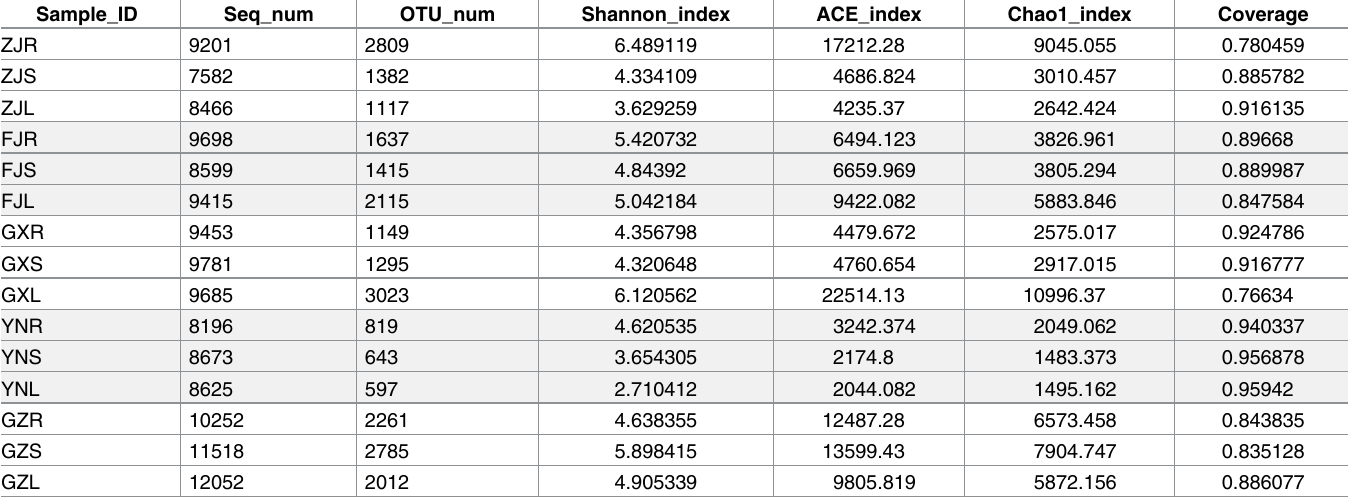
Table 2. Diversity indices of the D . catenatum